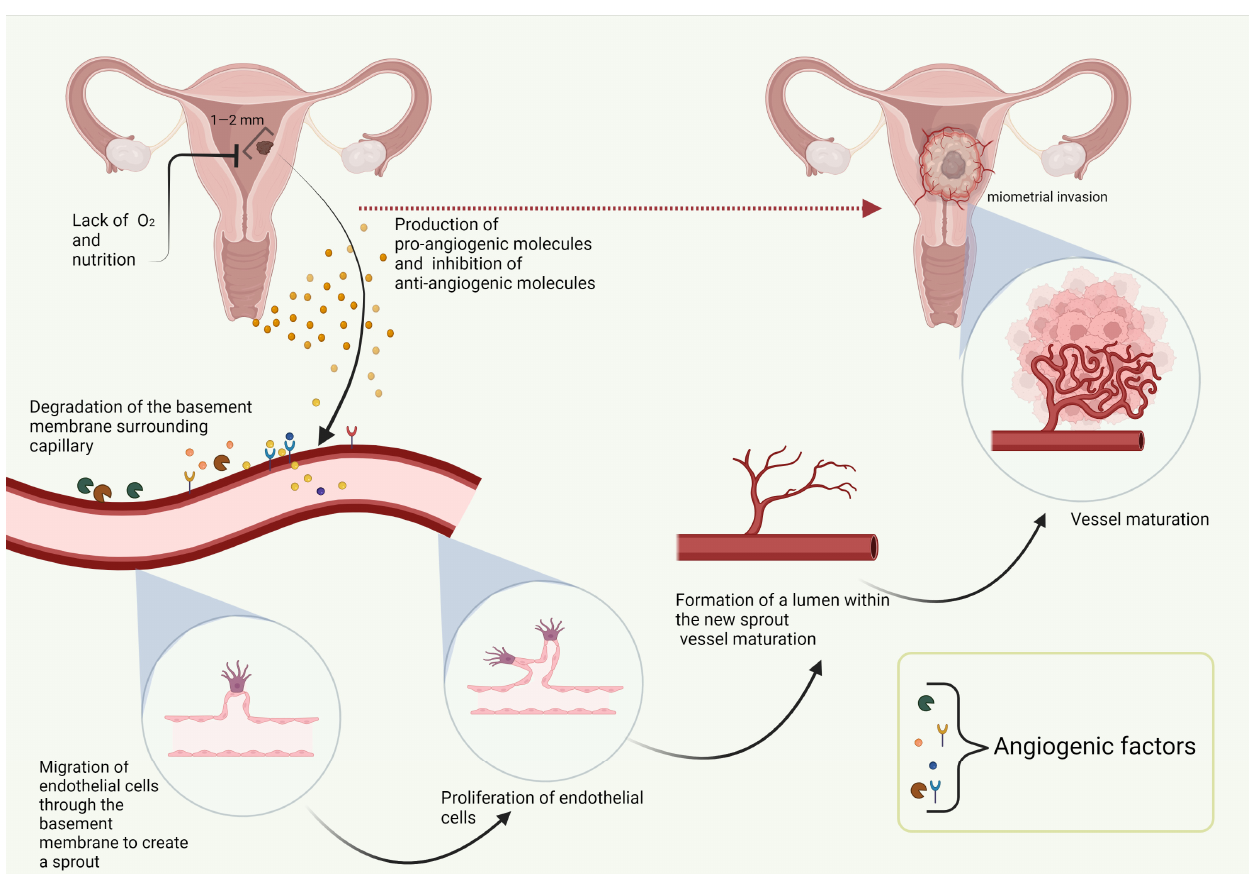
Figure 1. Angiogenesis in endometrial cancer. Created with BioRender.com.